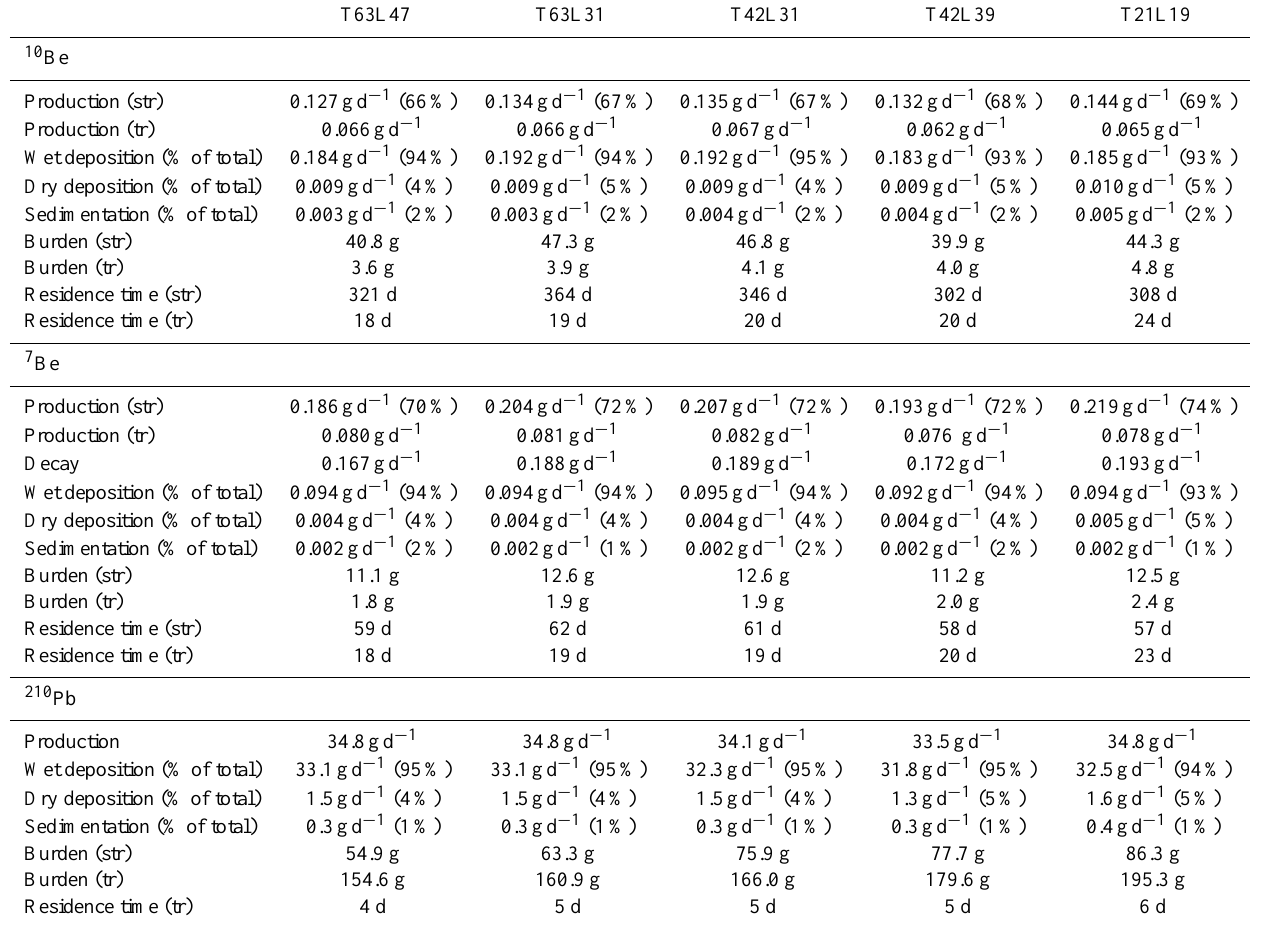
Table 2. Globally integrated budgets and residence times of 10 Be, 7 Be and 210 Pb at different model resolutions (1998–2002 mean). str=stratosphere, tr=troposphere. (% of total) shows the share of total deposition.